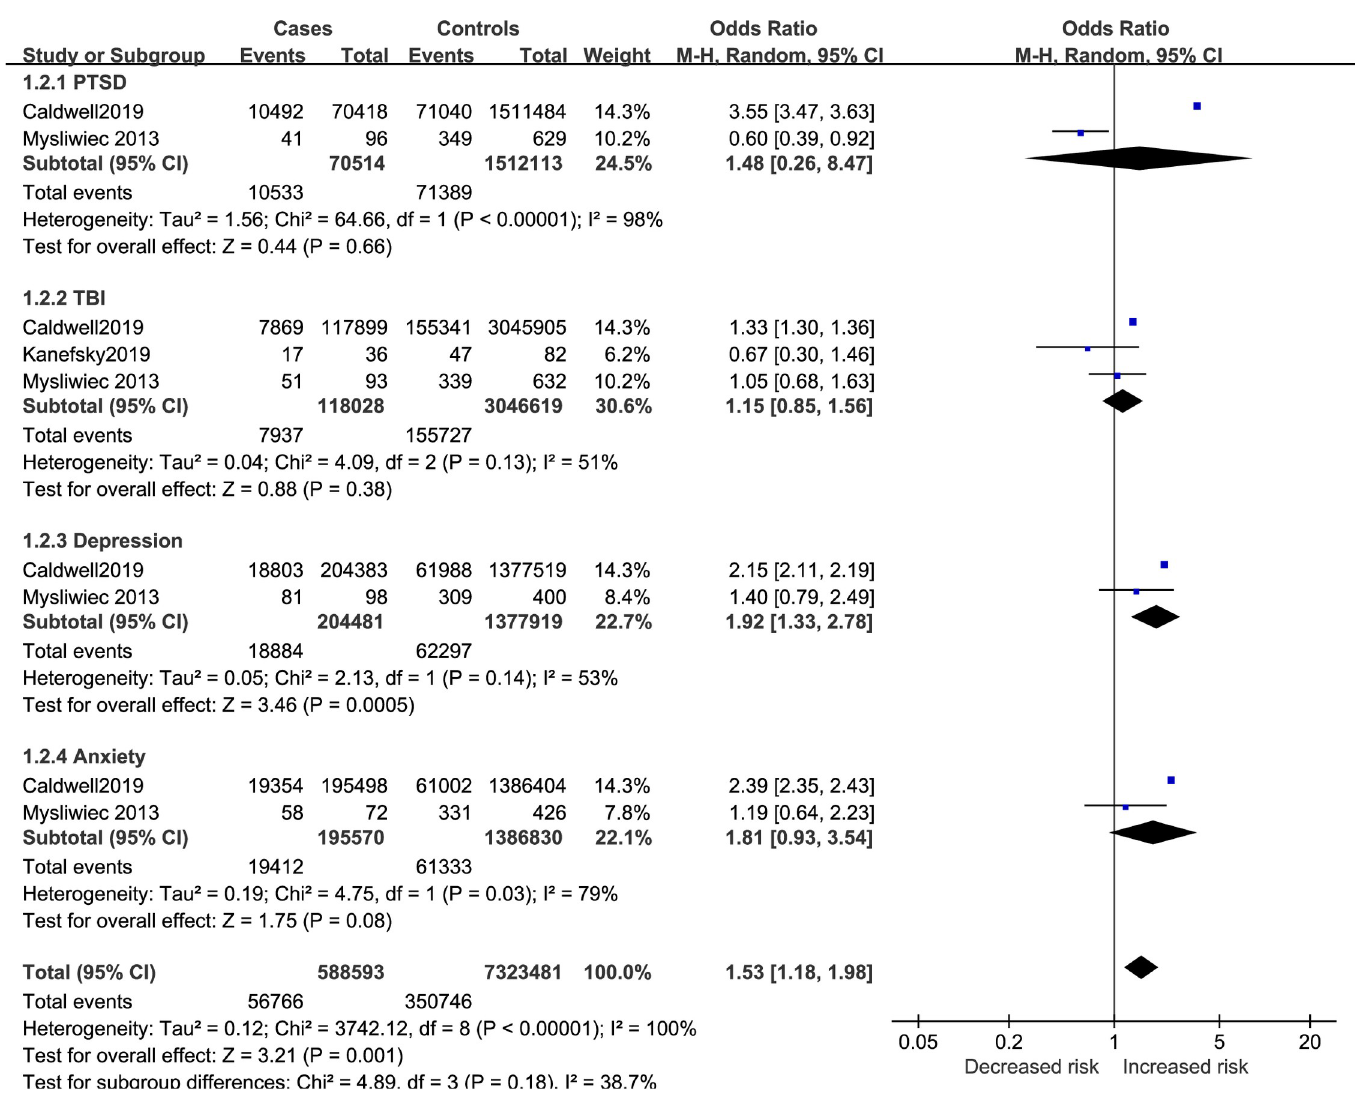
Fig 3. Comorbidity factors for SDB in active-duty personnel. data analysis [13]. Depression (OR = 4.50, 95%CI 1.57 to 12.87), PTSD (OR = 6.21, 95% 3.84 to 10.02), TBI (OR = 1.79, 95%CI 1.75 to 1.82), and anxiety (OR = 4.14, 95%CI 2.01 to 8.50) could increase insomnia risk. Total effect of the four comorbidities was found to increase insomnia risk with a relatively large effect (OR = 3.61, 95%CI 2.82 to 4.63). Risk factors for insomnia in veterans Sociodemographic factors. Results of sociodemographic factors for insomnia risk in vet- erans are reported in Fig 8. Being white (OR = 0.64, 95%CI 0.52 to 0.78) was related to lower insomnia risk. Aging (OR = 0.90, 95%CI 0.52 to 1.57), marriage (OR = 1.00, 95%CI 0.70 to 1.43), and male gender (OR = 0.94, 95%CI 0.79 to 1.12) had no significant influence for insom- nia risk.